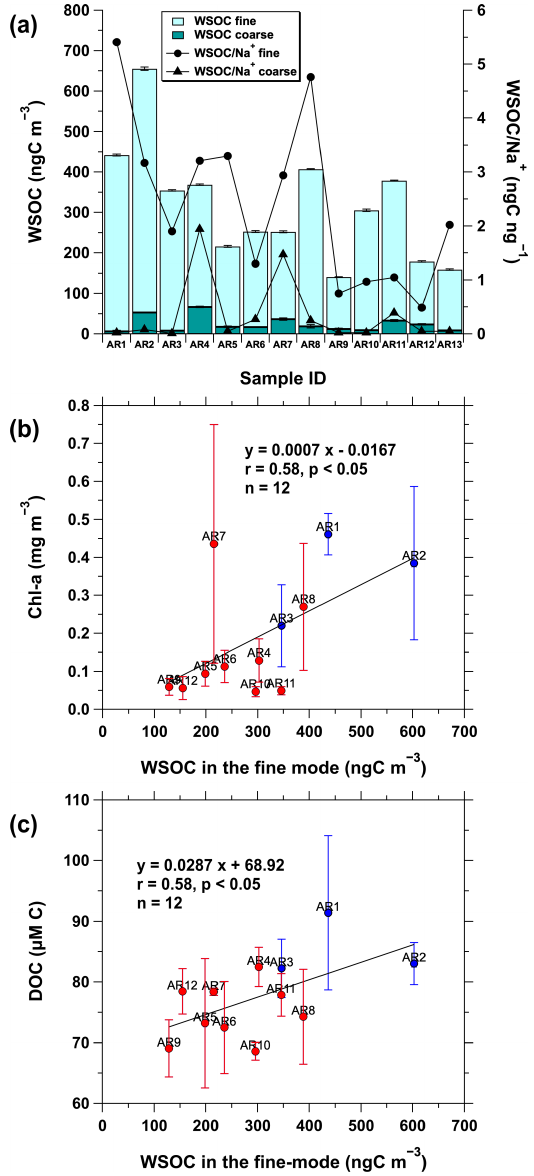
Figure 4. (a) Concentration of WSOC (ngCm − 3 ) and WSOC / Na + ratio (ngCng − 1 ) in both fine- ( D < 2 . 5µm) and coarse-modes aerosols (2.5µm < D < 10µm). Relationships of WSOC concentration in the fine-mode aerosols (ngCm − 3 ) with (b) in situ surface chlorophyll a (Chl a ) concentration (mgm − 3 ) and (c) surface dissolved organic carbon (DOC) concentration (uMC). Chl a and DOC concentrations are presented as their mean values and standard deviations for each aerosol sampling time. The solid blue and red circles in (b) and (c) indicate the samples collected from the coastal and sea-ice-covered areas, respectively. Chl a and DOC concentrations were not measured during the collection of the AR13 aerosol